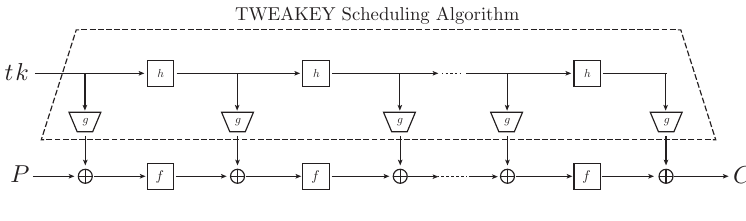
Figure 1: Key-alternating tweakable block cipher with linear tweak schedule.